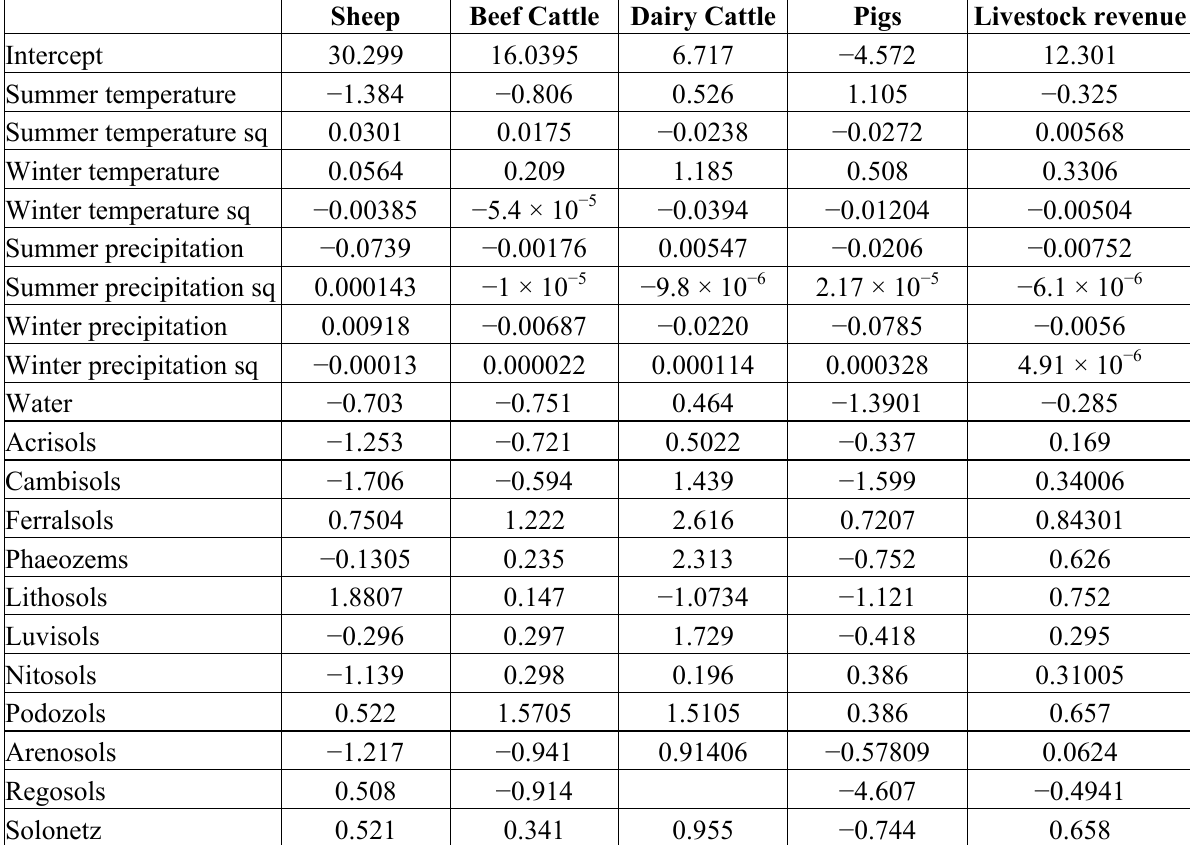
Table 8. Analysis of feed